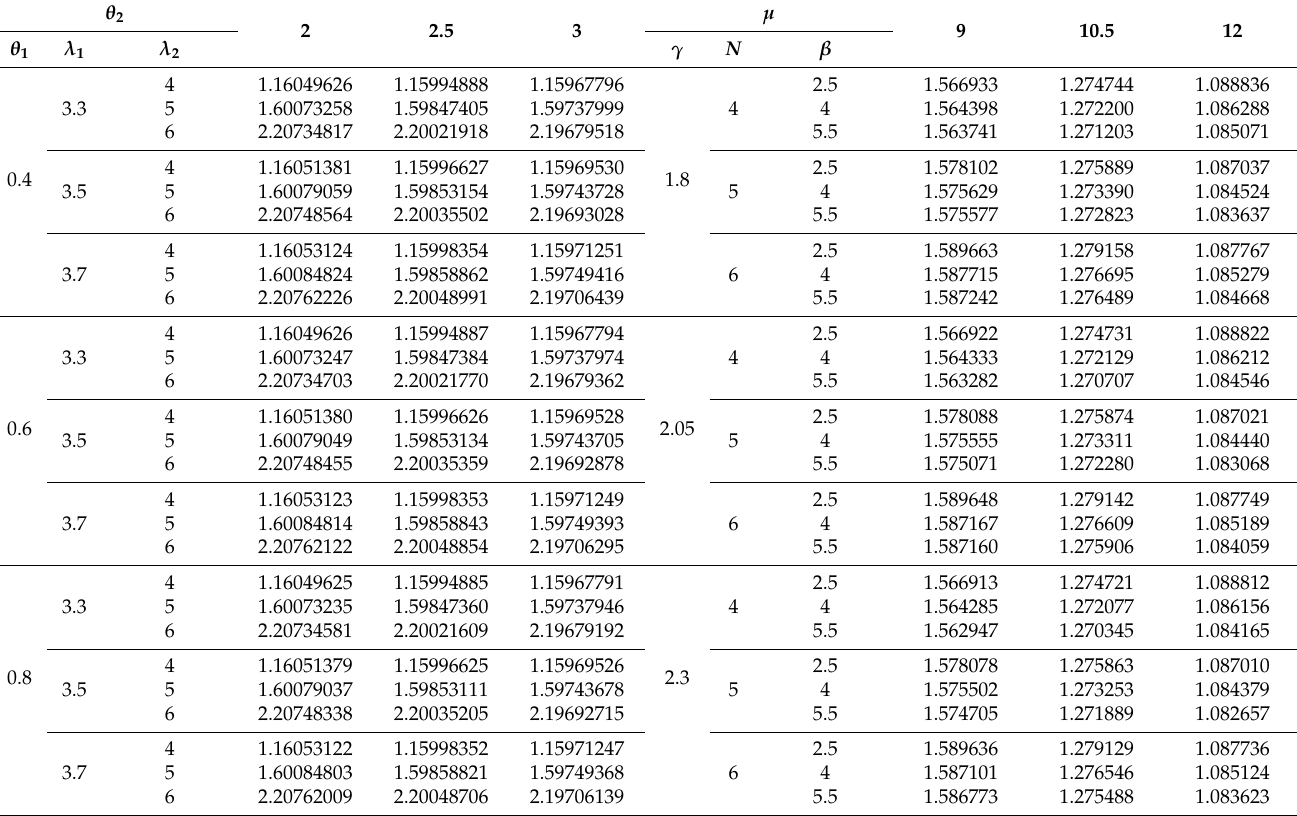
Table 1. Total cost under the parameter